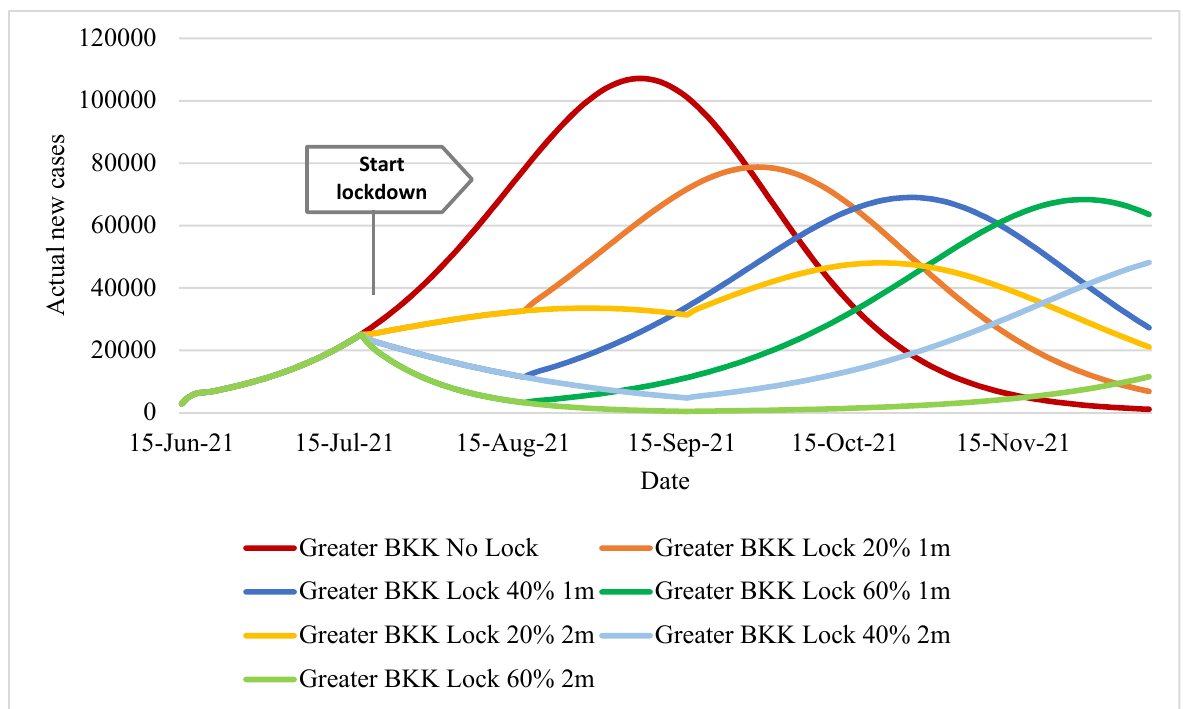
Figure 2. Daily (estimated) actual new cases in Greater Bangkok.